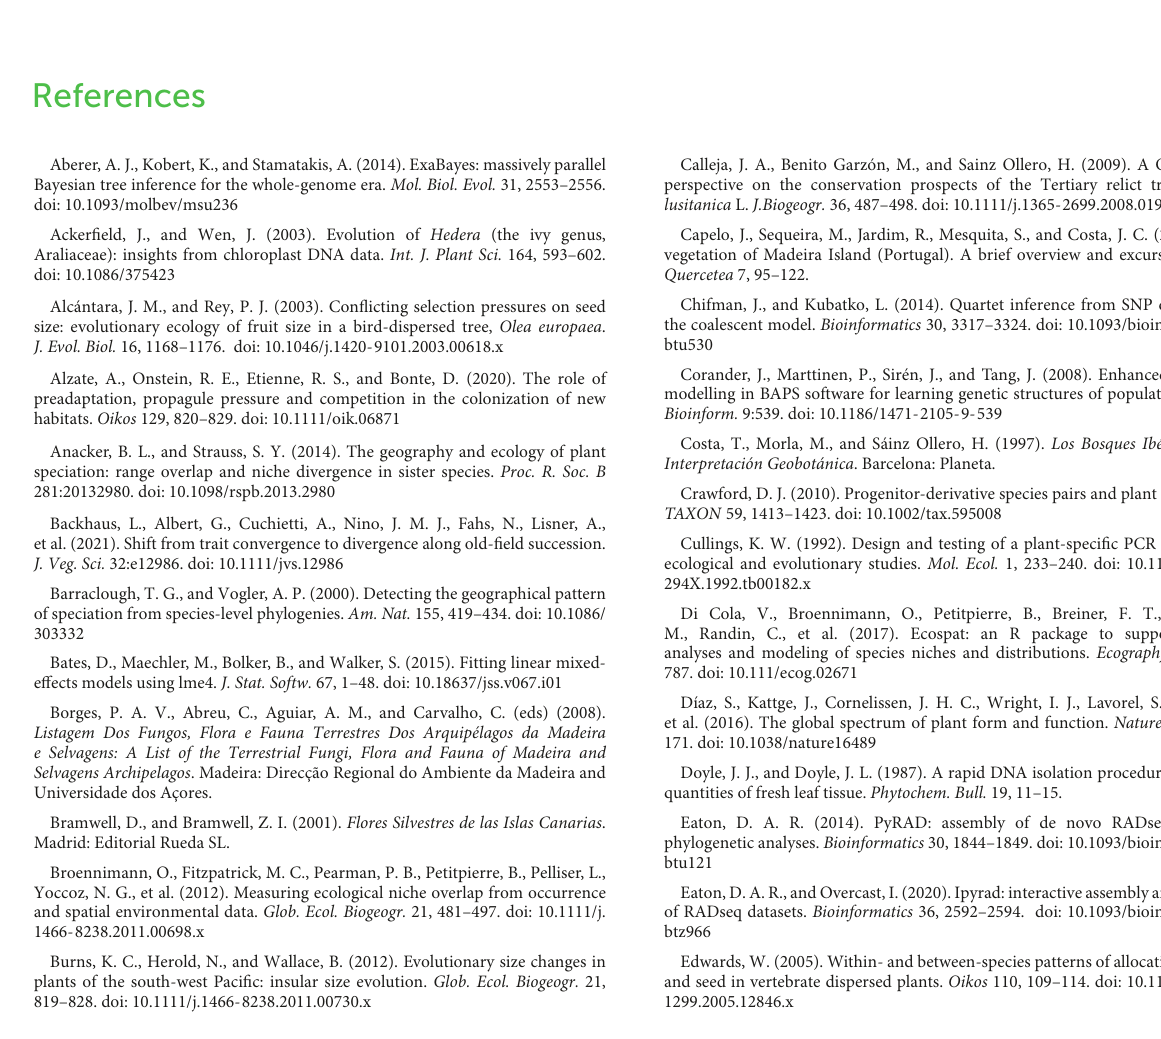
SUPPLEMENTARYFIGURE1 Correlogram of the 19 functional trait variables according to Pearson correlation coefficients. SUPPLEMENTARYFIGURE2 Diagnostic plots of the mixed models of functional trait variables. SUPPLEMENTARYFIGURE3 Consensus tree from the coalescent-based SVDquartets analysis. SUPPLEMENTARYFIGURE4 Consensus trees from the RAxML analyses of the 36 datasets. SUPPLEMENTARYFIGURE5 Results from population genetic structure analyses (genetic PCA and BAPS). SUPPLEMENTARYFIGURE6 Violin plots of the first two axes of the climatic PCA. SUPPLEMENTARYFIGURE7 Violin plots of the functional